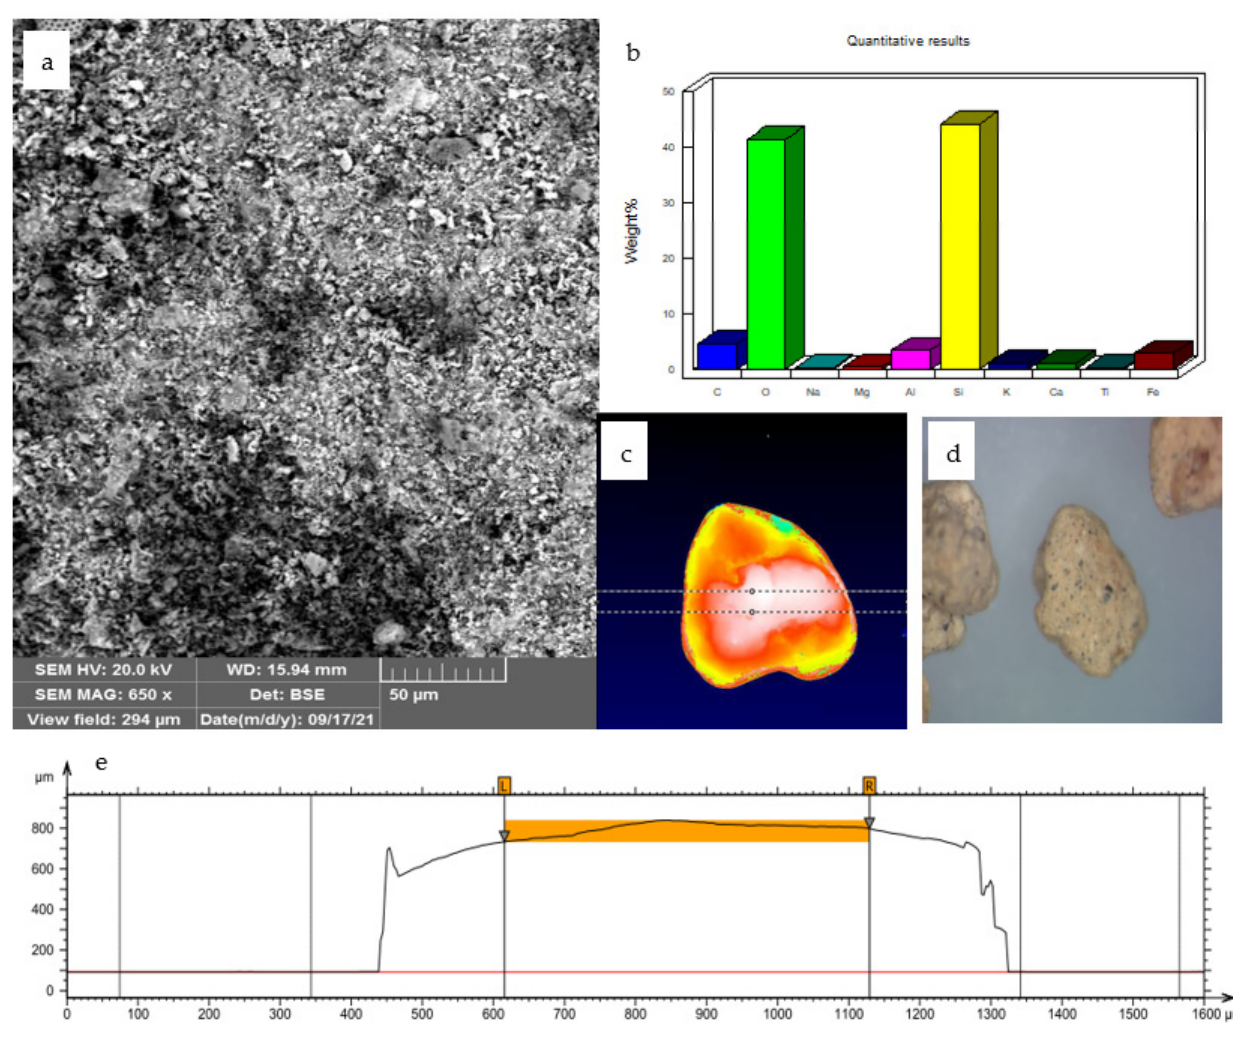
Figure 2. Absodan Plus: ( a ) SEM surface micrograph (650 × ), ( b ) content of identified elements diatomite, ( c ) 2D image ( d ) stereoscopic image, ( e ) topography layer (extracted profile: maximum height 747 µ m, mean height 710 µ m). Table 4. Crystallinity and the amorphous ratio of Absodan Plus take into account the size of